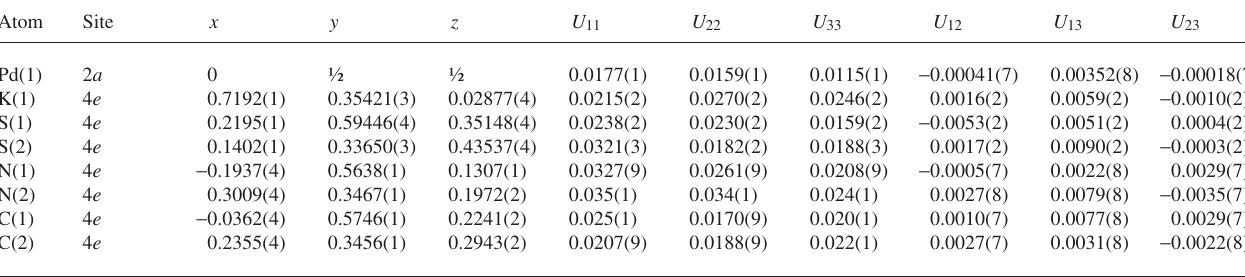
Table 2. Atomic coordinates and displacement parameters (in Å 2 )